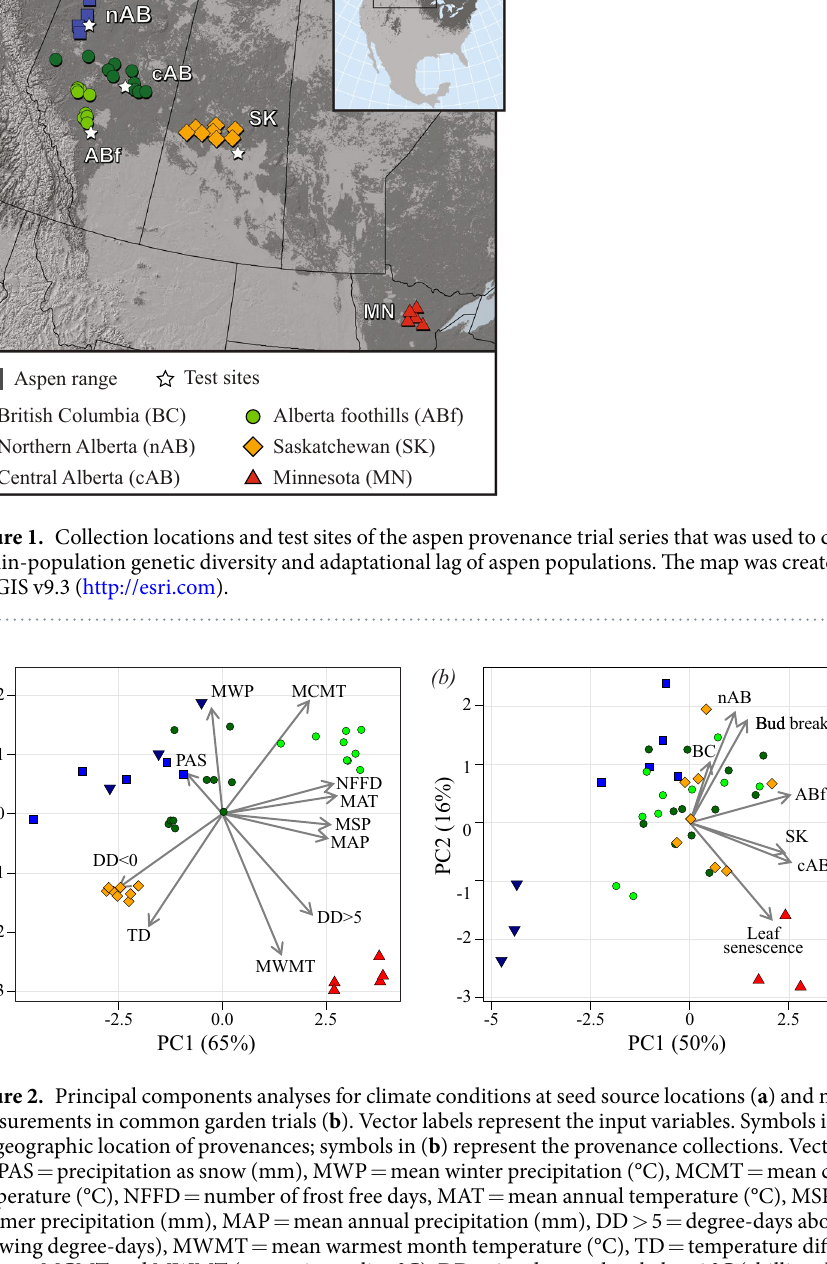
diversity across aspen’s main boreal distribution from southeastern Minnesota to northwestern British Columbia is apparent in all measured traits ( cf . Fig. 1). The gradient is most pronounced for height measurements (0.94 in MN to 0.61 in BC), and height measurements also have the highest accuracy of within-population diversity estimates, because they were evaluated at five sites. With respect to timing of bud break, all western Canadian provenances are fairly homogenous only contrasting with the Minnesota provenances with much higher